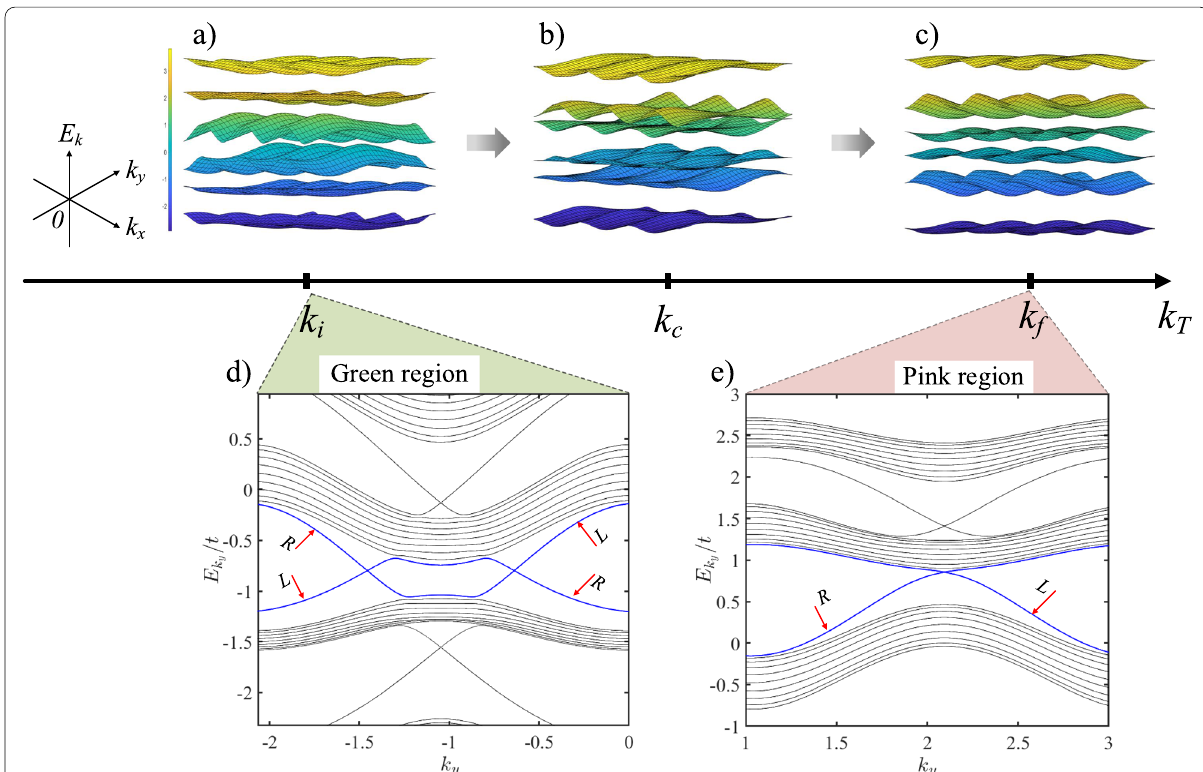
Fig. 5 Energy dispersions vs Bloch vector k with photon momentum k T . k i , k c , and k f are three special k T chosen for a , b , and c , respectively. d and e are enlarged energy dispersion vs photon momentum k T in order to illustrate edge bands and their location along x direction. The left and right boundaries are marked as L and R , respectively. The photon momentum chosen are in a and d k T = 0.3 , in b k T = 0.84 , and in c and e k T = 1.2 . Other parameters chosen are α = 1 / 3 , β = 0.2 π , a = 1 , and W =